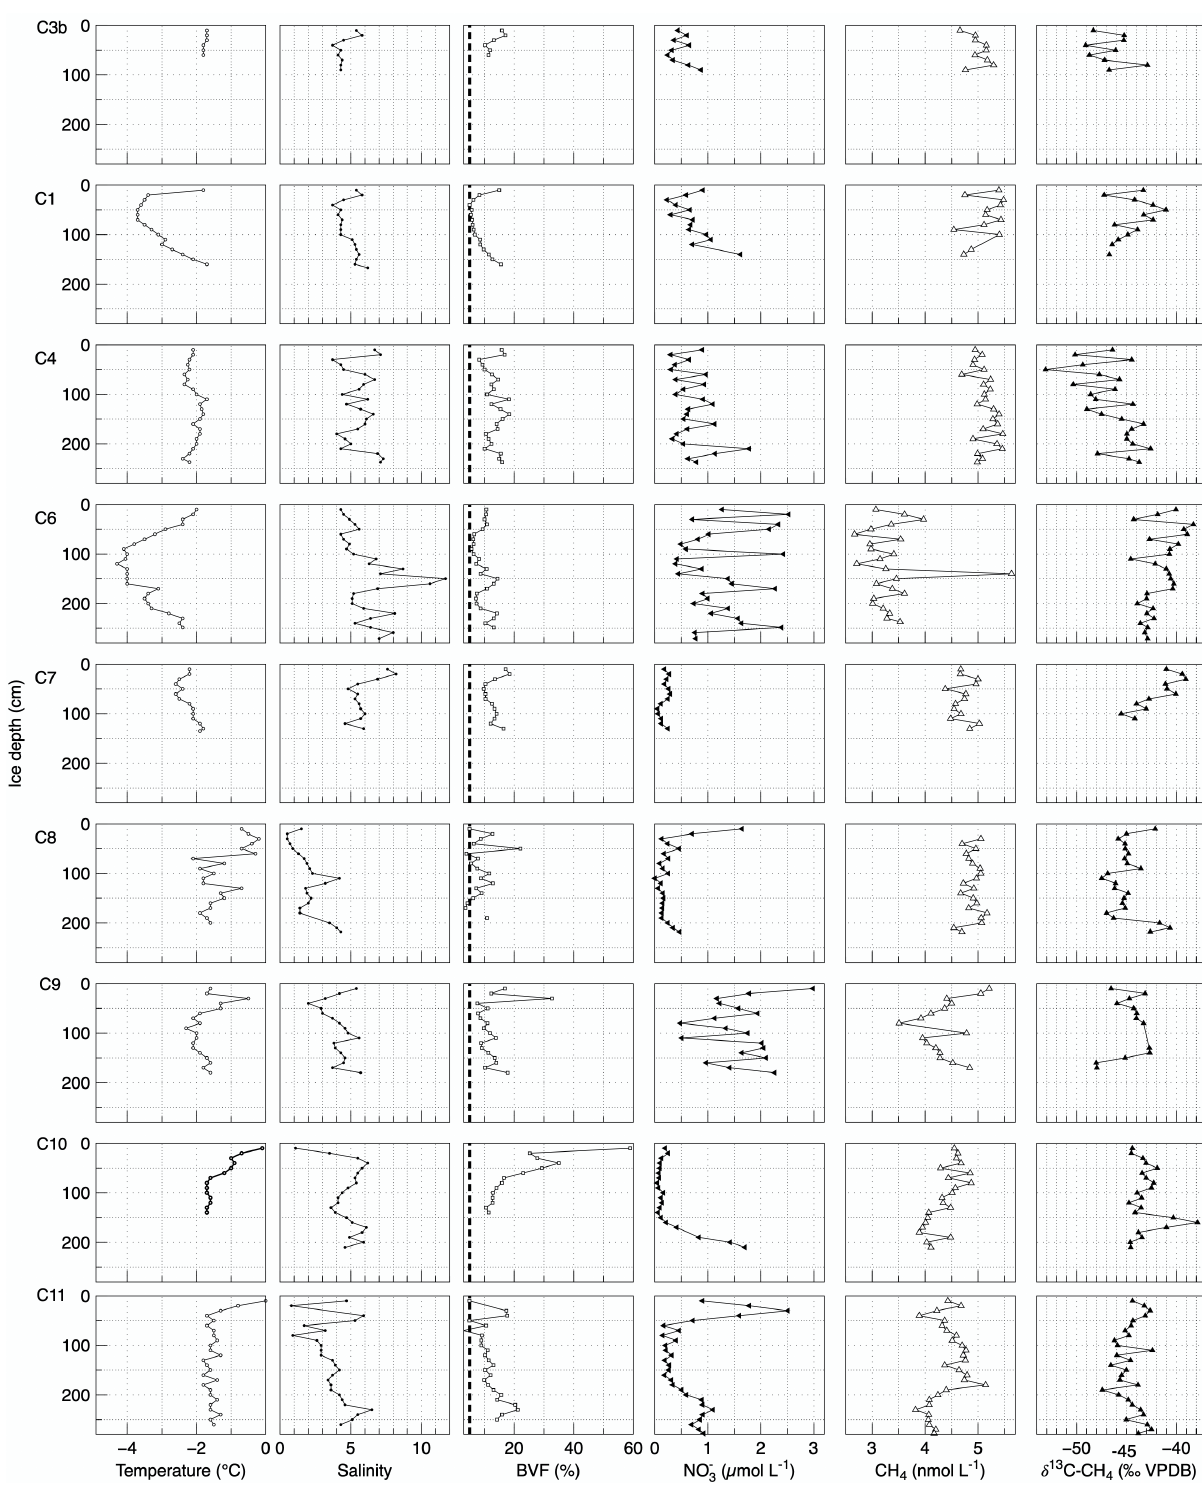
Figure 2. Temperature, salinity, brine volume fraction (BVF), nitrate (NO − signature of methane ( δ 13 C-CH 4 ) from sea ice cores taken across the ice floe. Dashed black line in BVF indicates when values are < 5%, corresponding to impermeable sea ice (Golden et al.,